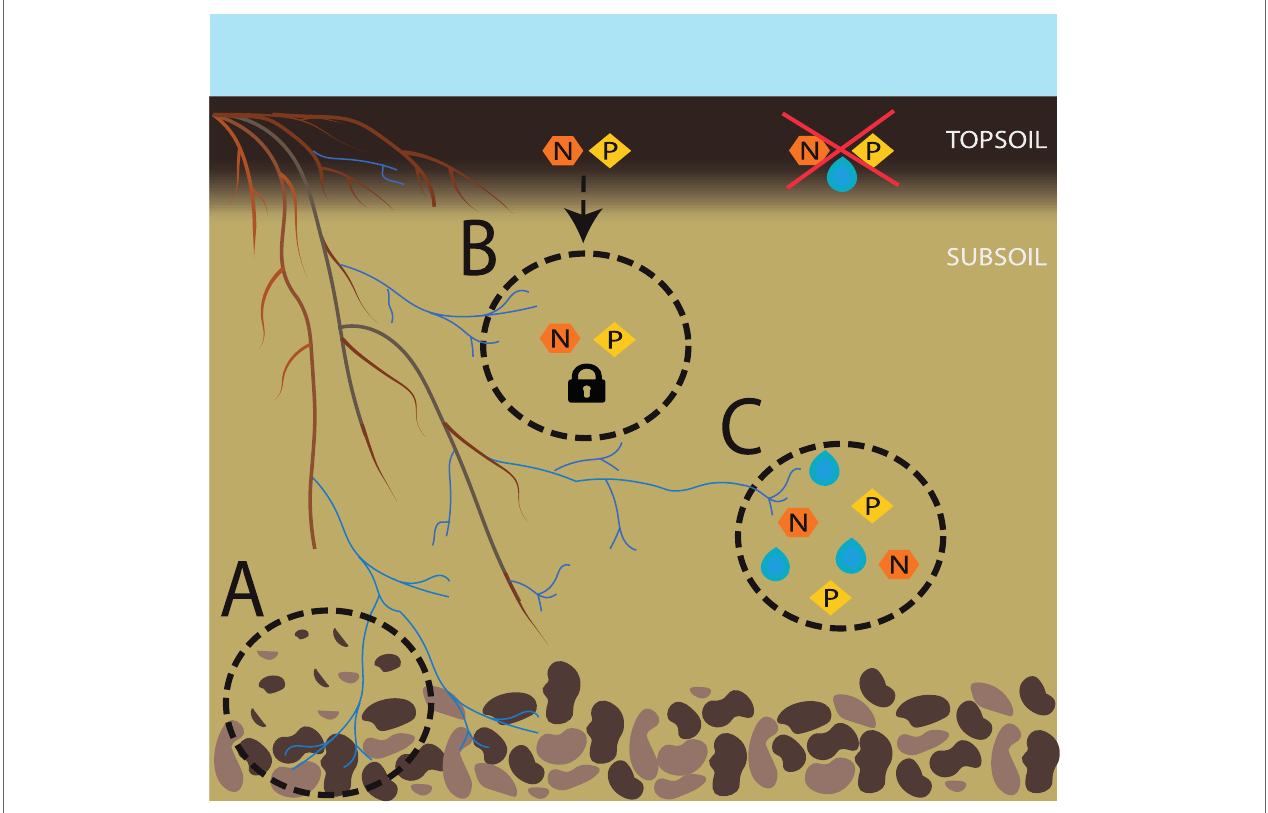
FIGURE 1 | Subsoil AM fungi for sustainable agriculture. Overview of the contributions of subsoil AM fungi to a sustainable agriculture. (A) Enhanced soil formation; (B) reduction of nutrient leaching; (C) access to deep nutrient and water pools, particularly when suboptimal conditions prevail in the